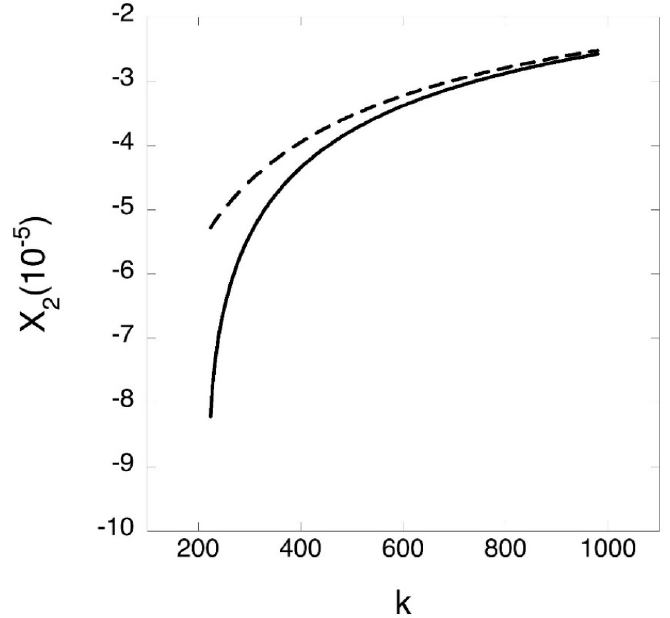
Figure 2. The coordinate x 2 of the top of the potential barrier versus the scaled pseudomomentum k for the scaled magnetic field b = 1.3 × 10 6 (corresponding to B = 5 Tesla). The solid line is the exact result from Equation (32), the dashed line—the asymptotic result from Equation (20). Figure 3 shows the scaled energy E s = V s,top at the top of the potential barrier versus the scaled pseudomomentum k for the scaled magnetic field b = 1.3 × 10 6 (corresponding to B = 5 Tesla). The solid line is the exact result from Equation (34), the dashed line—the asymptotic result from Equation (23). It is seen that even for values of k close to k min , the difference is practically negligible. Thus, Equations (25) and (29), obtained by using the asymptotic value of V s,top from Equation (23), yield the sufficient accuracy.